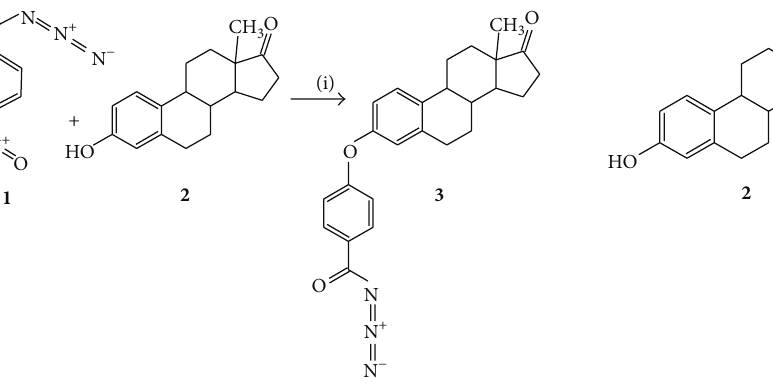
Figure 1: Synthesis of 4-(13-methyl-17-oxo-7,8,9,11,12,13,14,15,16,17- decahydro-6-H-cyclopen ta[a]phenanthren-3-yloxy)-benzoyl azide ( 3 ). Reaction of 𝑝 -nitrobenzoyl azide ( 1 ) with estrone ( 2 ) to form 3 . (i) = potassium carbonate/dimethyl sulfoxide.